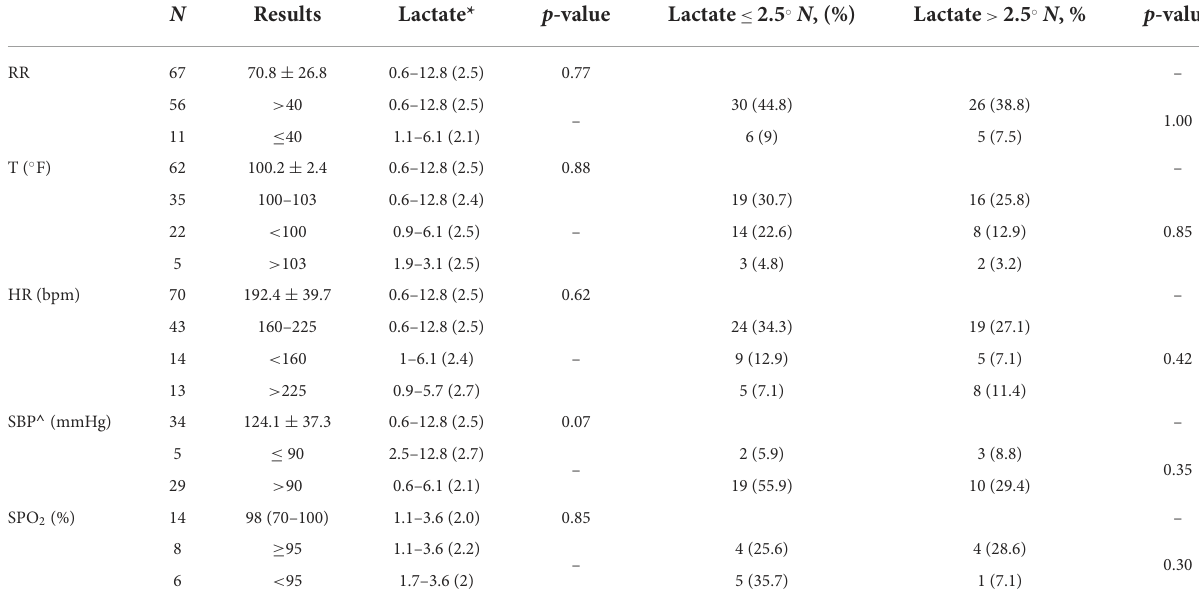
TABLE 1 Vital parameters and admission lactate concentration (mmol/L) in a population of 71 cats presented in respiratory distress to the emergency room. N